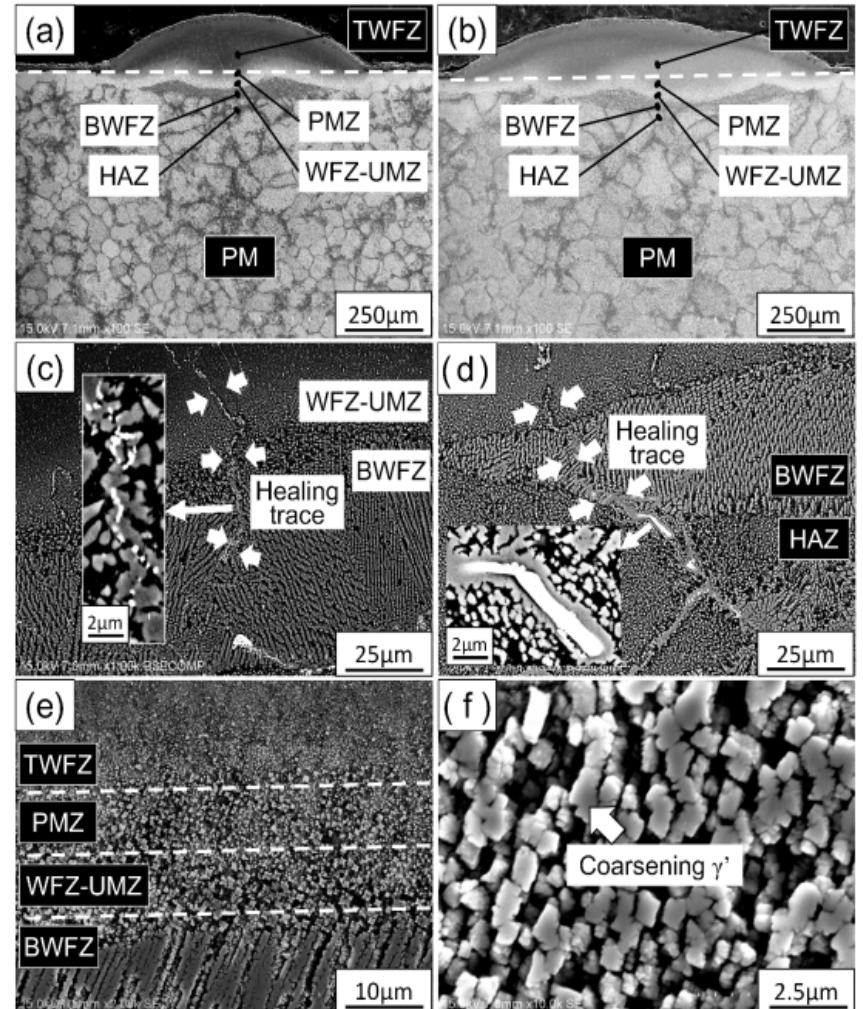
Figure 4. After HIP, an overview of the repair welding under ( a ) welding Condition B and ( b ) Condition C, ( c ) nano- and micro-sized carbides along the healed crack trace, and ( d ) large-sized carbides after the HIP process. ( e ) Various regions were observed in WFZ and ( f ) γ′ in HAZ after the HIP process.